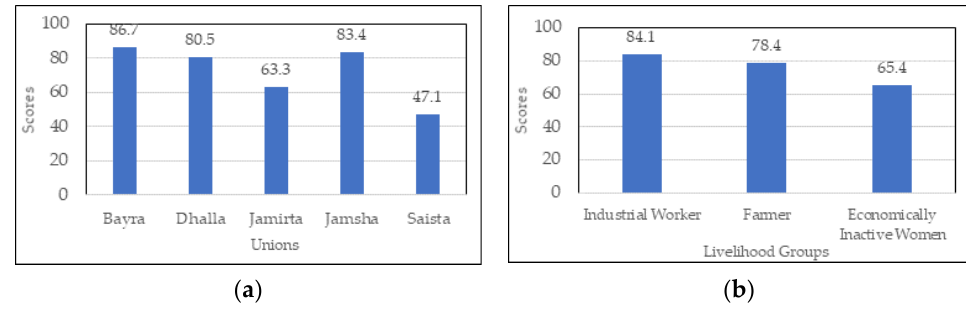
Figure 9. Score for use component for: ( a ) 5 unions; and ( b ) livelihood groups.